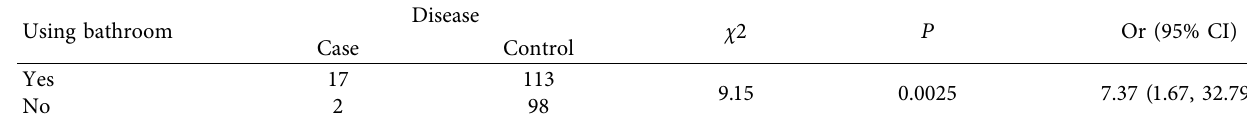
Table 3: Analysis of the relationship between using bathroom and disease.